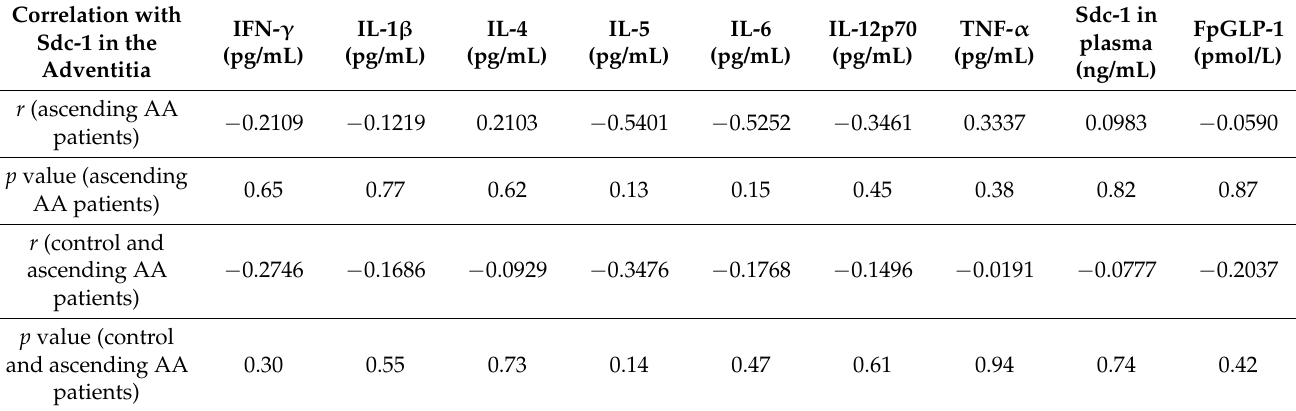
Table 3. Correlation of the Sdc-1 Expression in the Adventitia and Different Variants in